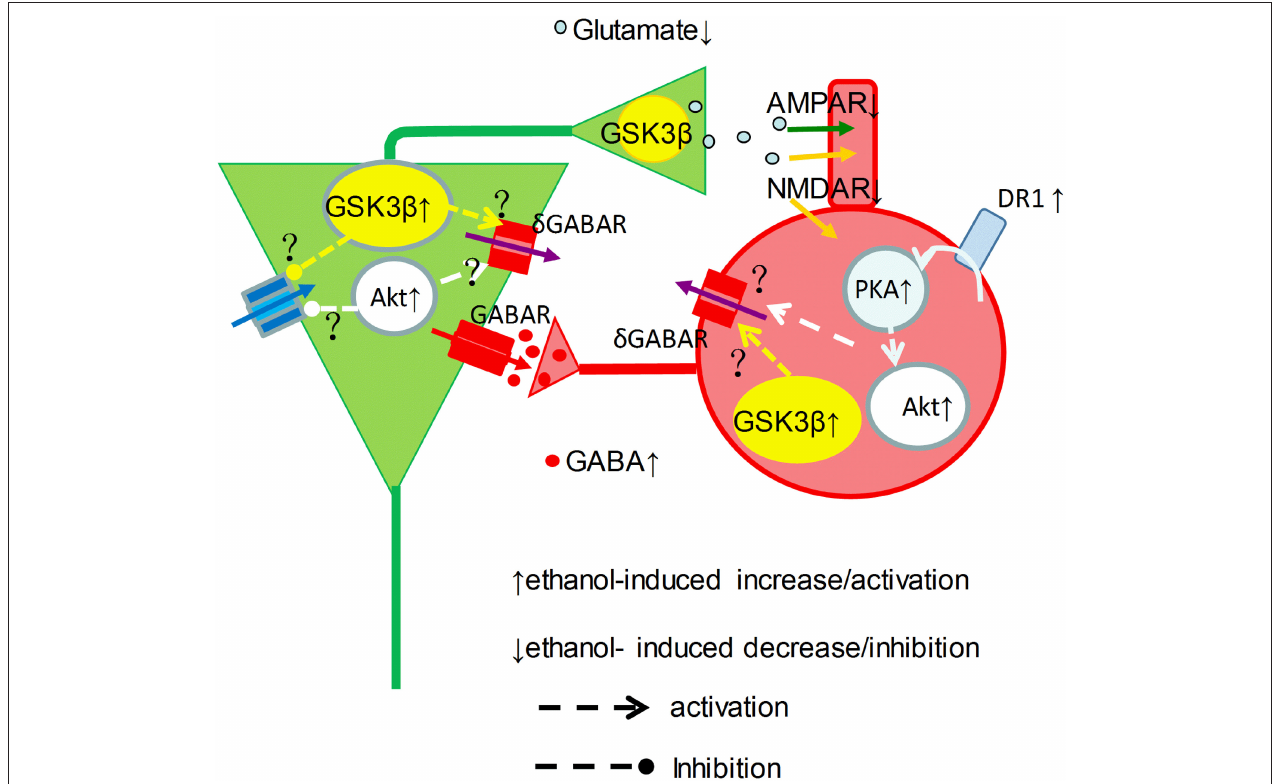
FIGURE 7 | Graphical representation of proposed ethanol-induced changes to the γ -generating network. Cellular excitability resulting from a tonic drive by intrinsic properties (blue arrow), NMDAR (orange arrow) and tonic δ GABAR (purple arrow), is shaped by phasic GABAR (red arrows) and AMPAR (green arrows) activity in pyramidal neurons (green) and interneurons (red) in a simplified γ -generating network. At intoxicated concentrations, ethanol activates DR1-cAMP-PKA signaling, and causes Akt and GSK3 β activation increase, which may increase phasic GABA release. On the other hand, ethanol inhibit NMDAR activity and increase δ GABAR activity, which can be mediated through activation of Akt and GSK3 β activation, reducing the excitatory drive and phasic glutamate release, suppressing γ